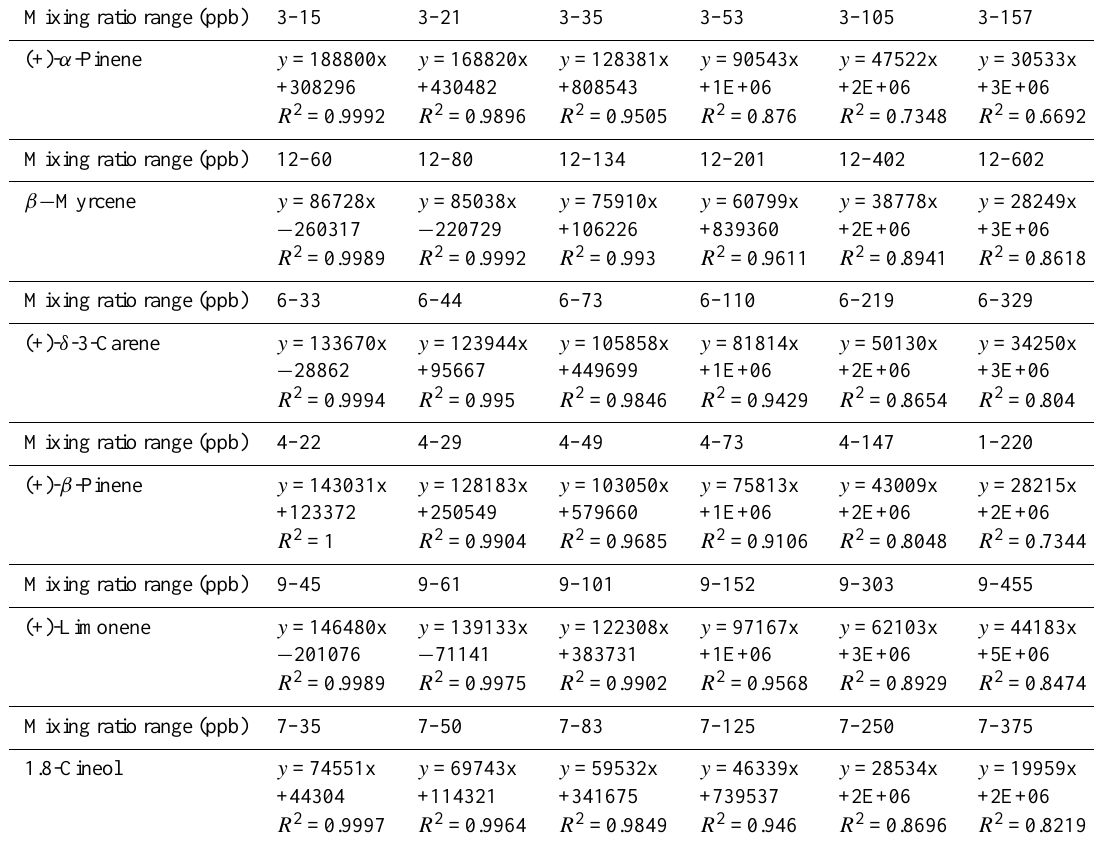
Table 3. Calibration curves with correlation coefficients of monoterpenes sampled from the glass sampling chamber using DVB-PDMS and CDS at different mixing